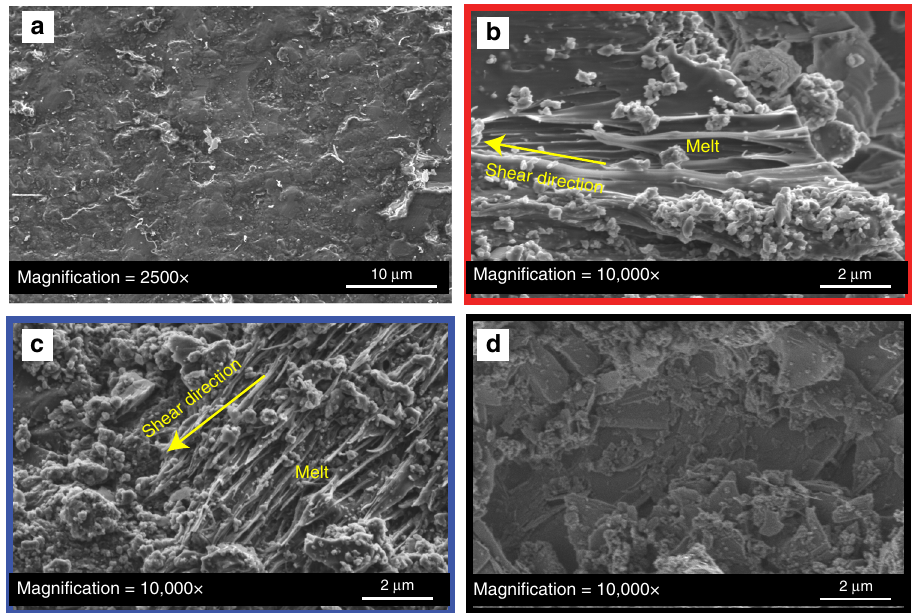
Fig. 3 Micrographs of the fault ’ s surfaces. Scanning electron microscopic images under secondary electron mode of half-fault surfaces. a Initial sample. Homogeneous surfaces with asperities of ~2 – 20 μ m. b Surface of the dry experiment. Surfaces were covered with clasts of sizes <5 μ m. Magni fi cation allowed observation of melted structures stretched along the shear direction. c Surface of the low fl uid pressure experiment. Clasts of sizes <5 μ m and melted patches were also identi fi ed. d Surface of the high fl uid pressure experiment. Clasts of sizes <5 μ m were found all over the surface. No melted structures were found